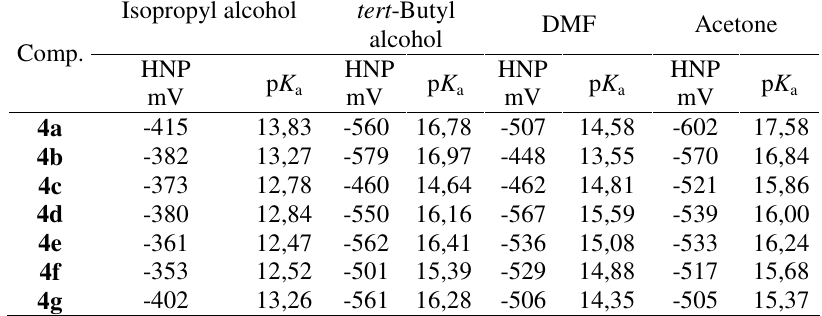
values of compounds 4a-g in isopropyl a